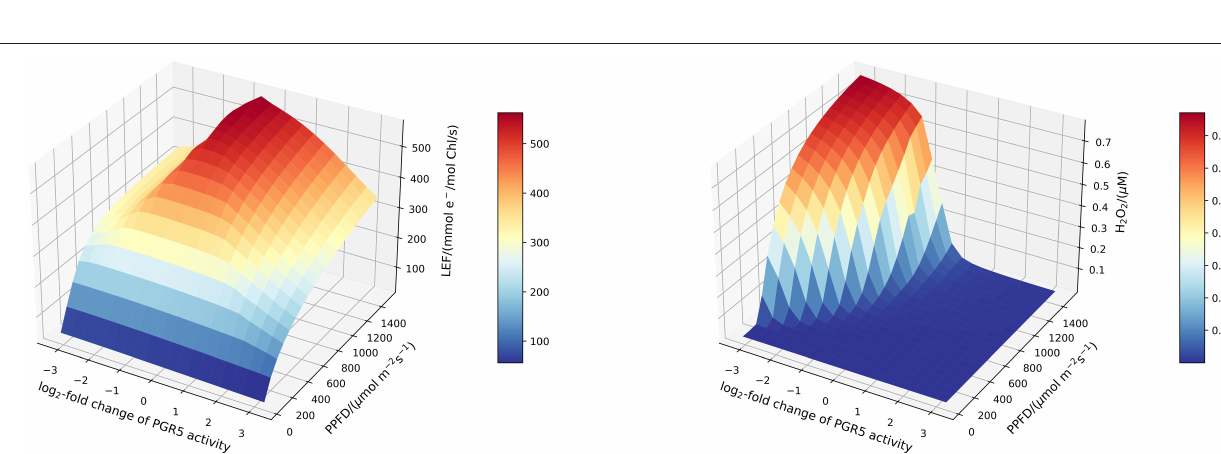
FIGURE 7 | Surface plots of the stationary linear electron flux (left) and H 2 O 2 concentration (right) in response to altered PGR5 (CEF) activity and light intensity. Increased CEF activity reduces stationary H 2 O 2 concentrations. For higher light intensities, more CEF activity is required to maintain low H 2 O 2 levels. This indicates that CEF activity should be regulated for maximal efficiency under various light